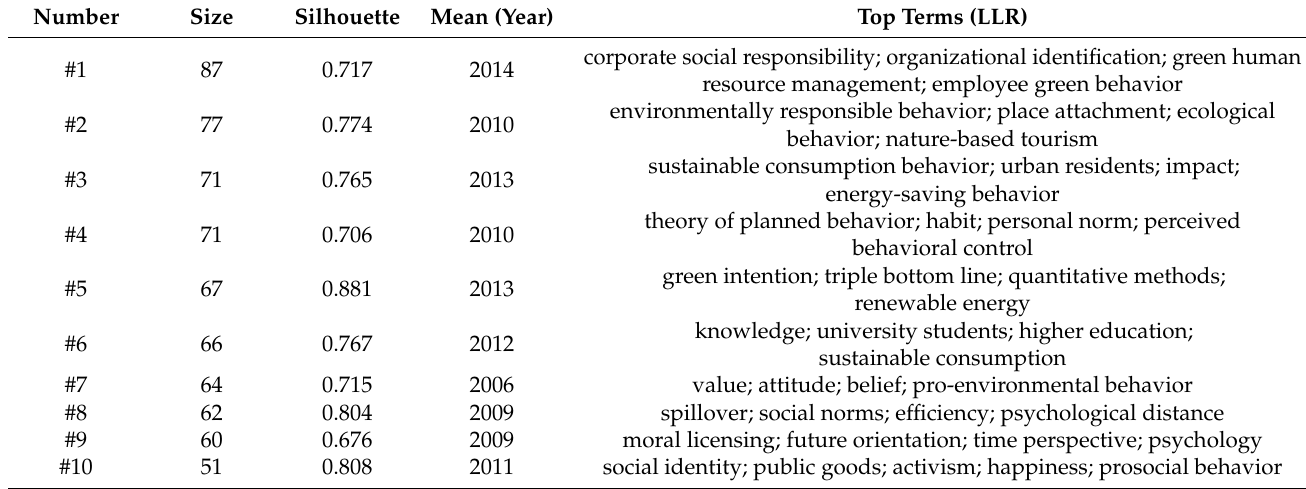
Table 2. Cluster analysis results (Top 10